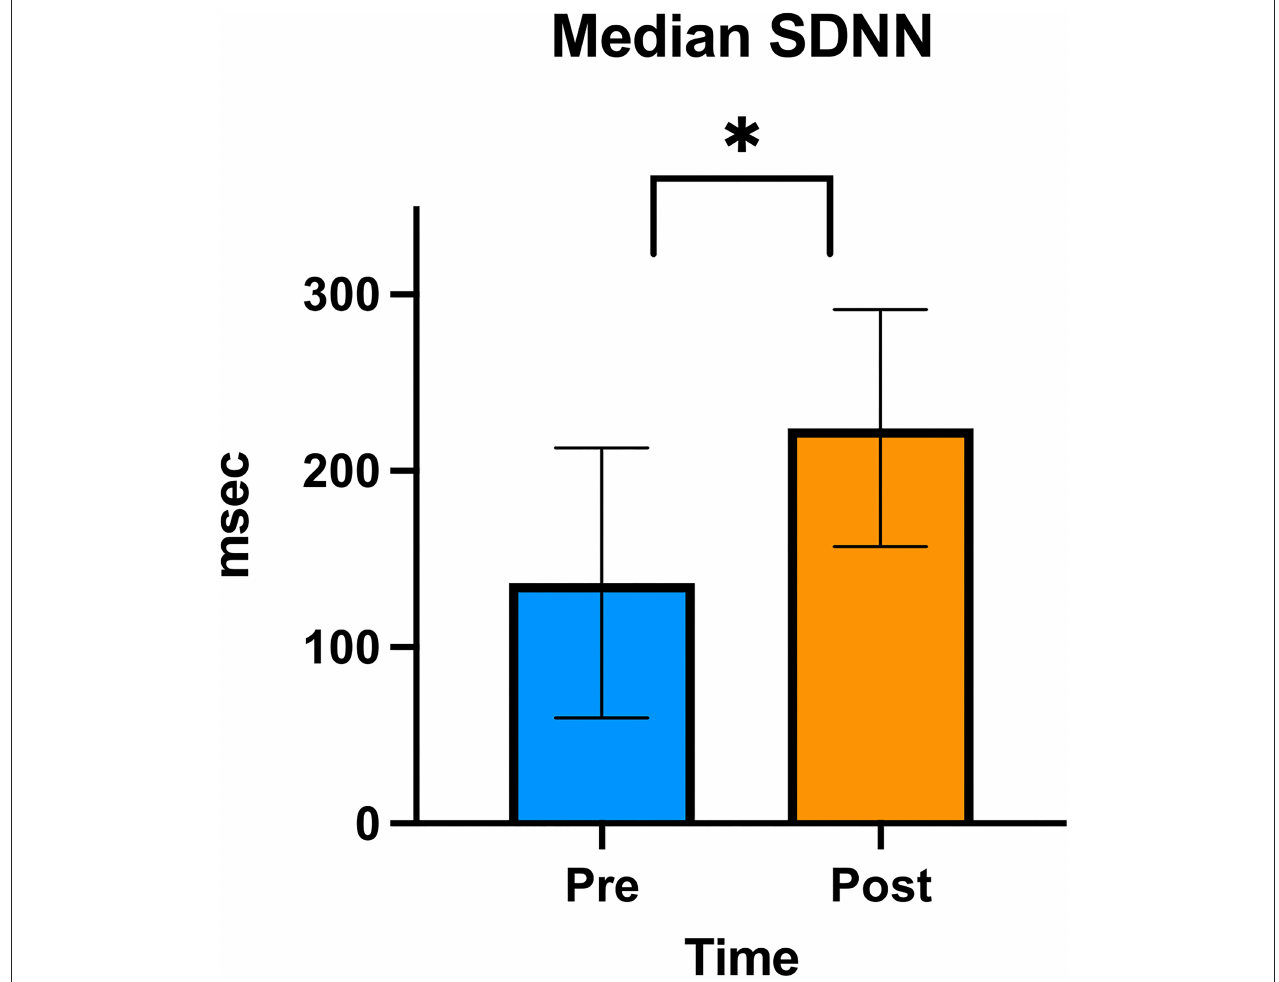
FIGURE 8 | SDNN graph. Column graphic of the SDNN index showing the difference between pre- and post-stimulation as measured on electrocardiogram in the group of 6 dogs. The upper and lower confidence intervals are represented in the graphic. An * denotes statistical significance ( p < 0.01).